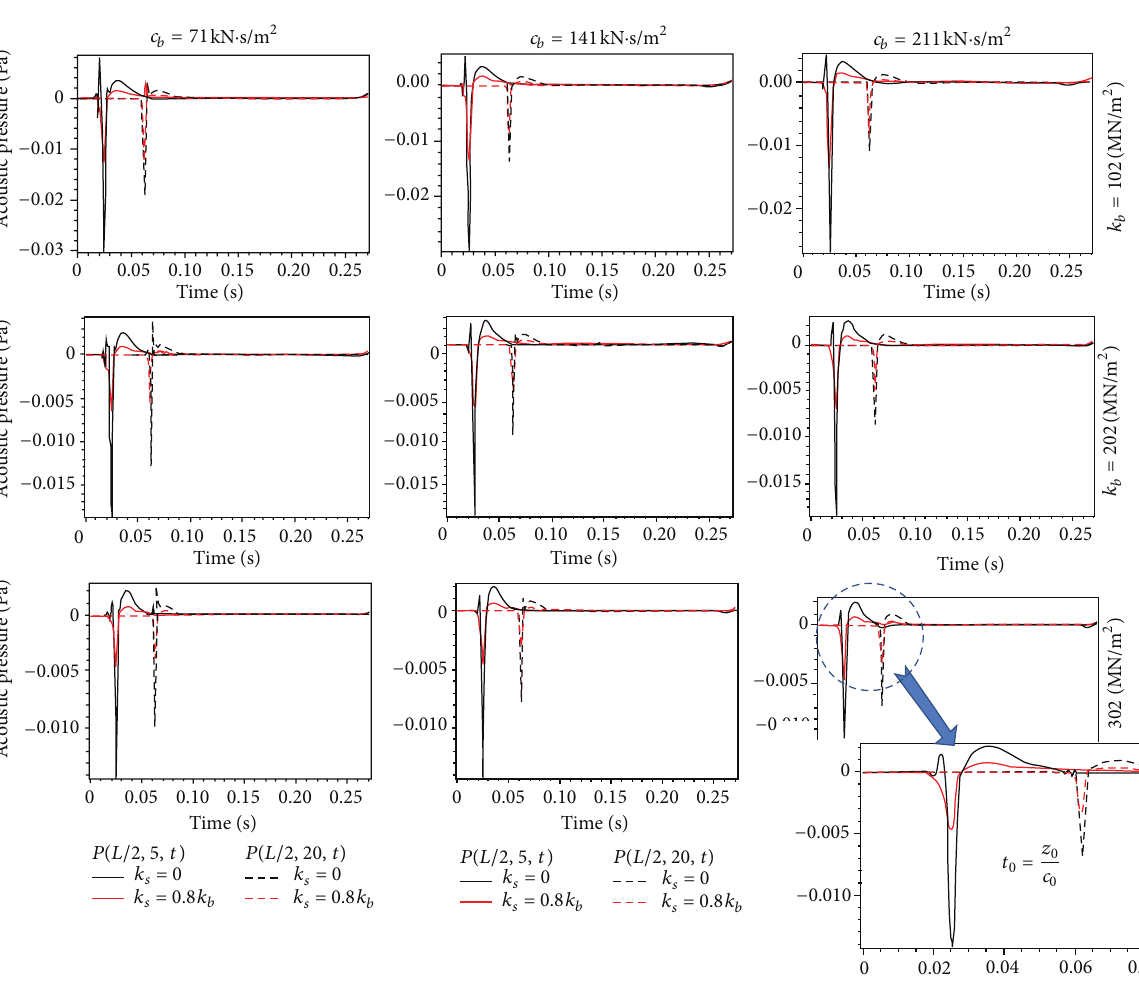
Figure 4: Acoustic pressure at different heights (midspan).